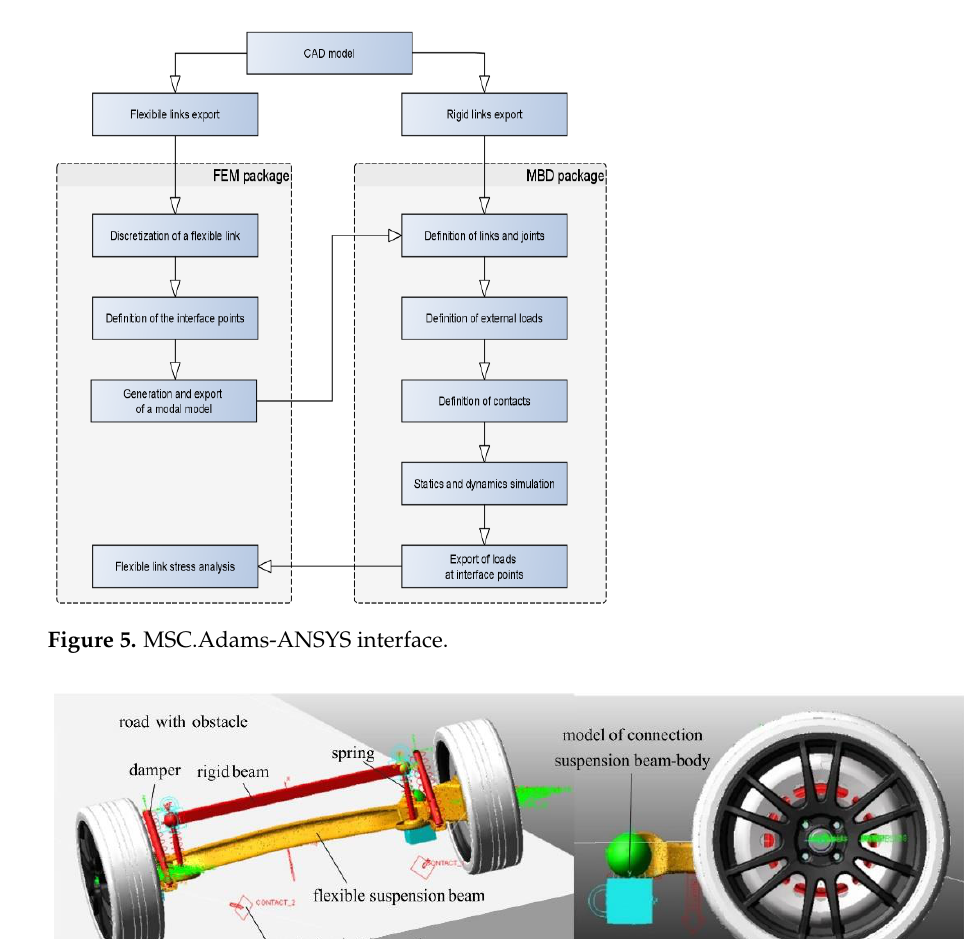
Figure 5. MSC.Adams-ANSYS interface.